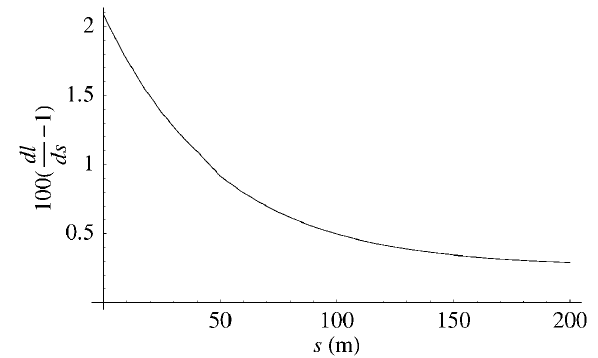
FIG. 8. An estimate of the error made by the paraxial